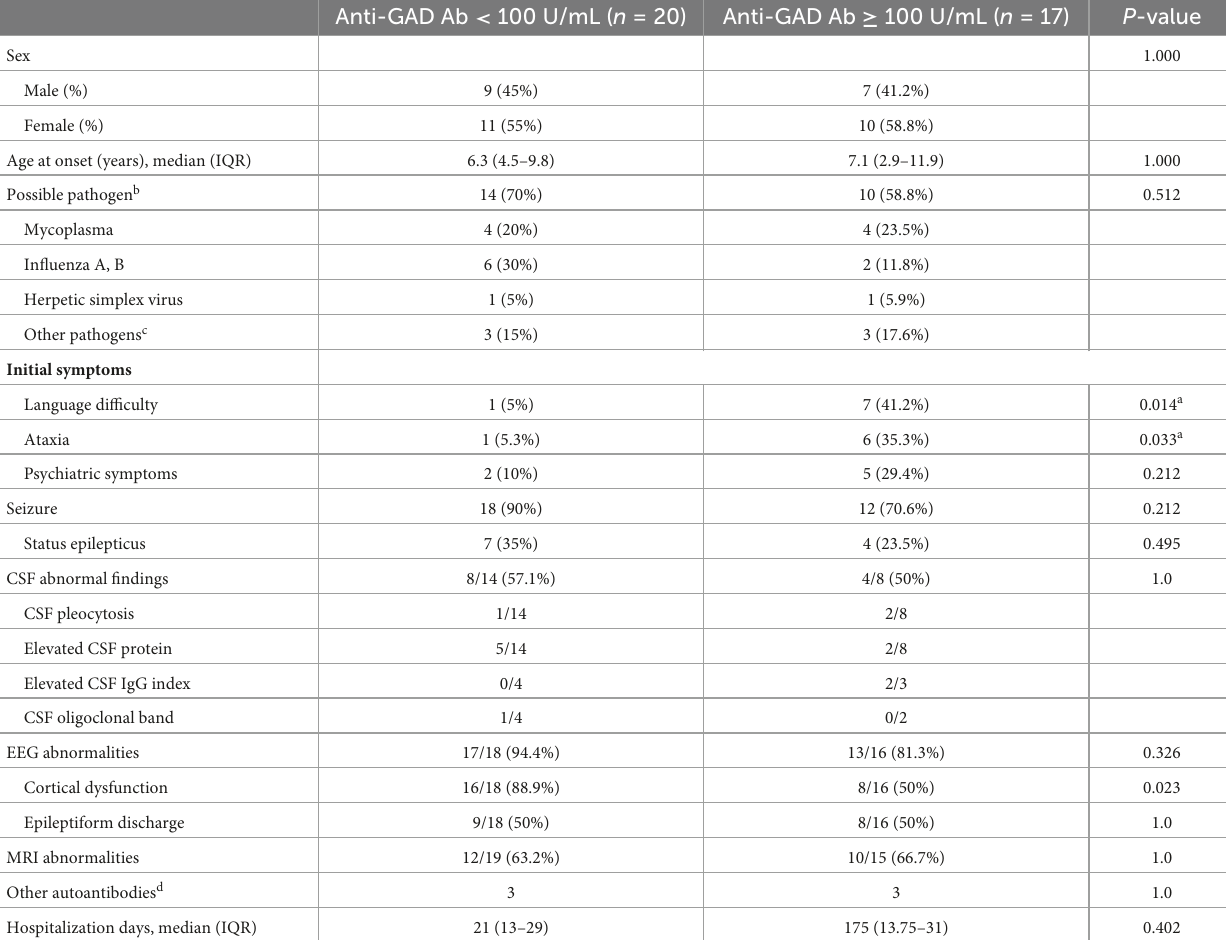
TABLE 1 Demographic data and clinical characteristics of the children with encephalitis/encephalopathy in the high- and low-titer anti-GAD antibody